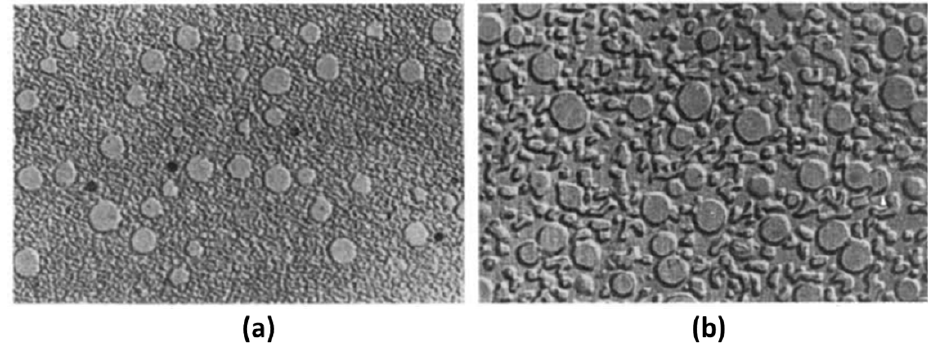
Figure 10. Electron microscope photographs × 18,900) of secondary phase separation in SiO 2 -Na 2 O glass with 12.5 mol% Na 2 O heat treated for 2 h at 777 ◦ C ( a ), and then heated at 668 ◦ C for 2 h ( b ) [133]. Reprinted with permission of Elsevier; published by Porai-Koshits and Averjanov,